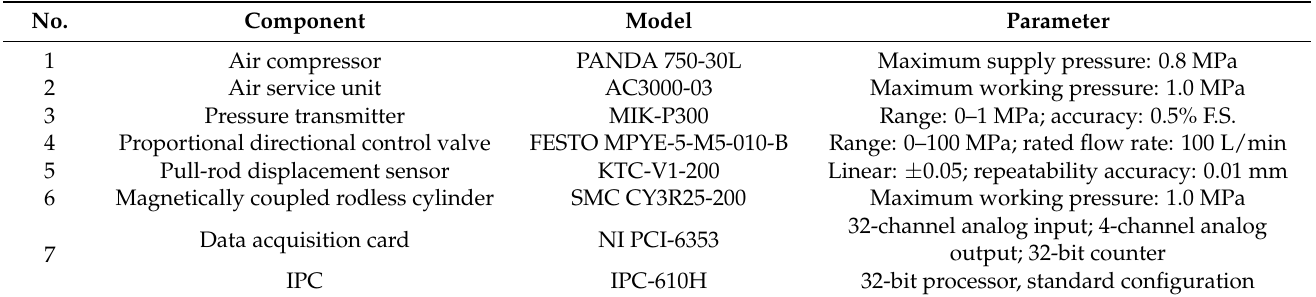
Figure 2. Experimental platform of the magnetic even rodless cylinder position servo control system. Table 1. Main components of the system.